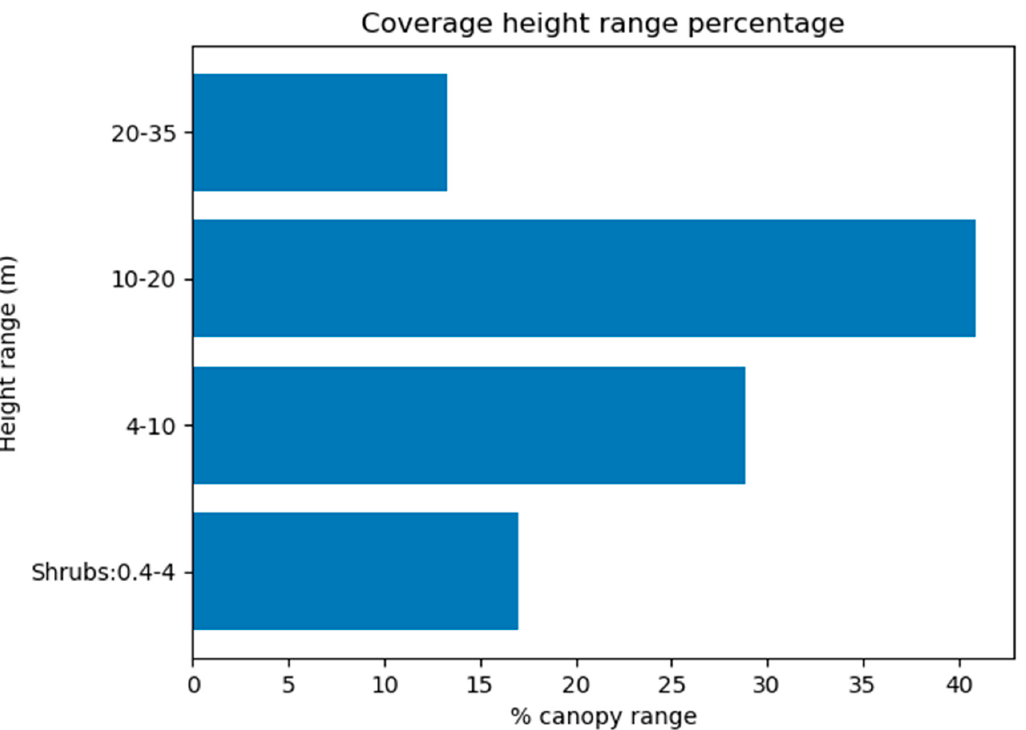
Figure 11. Coverage height range in study area for shrubs and tree height groups.